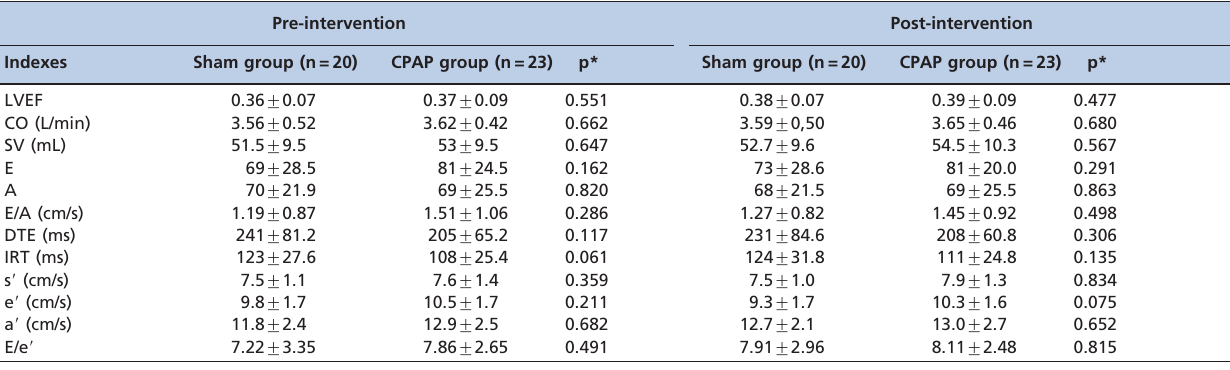
Table 3 - Systolic and diastolic function indices before and after intervention.